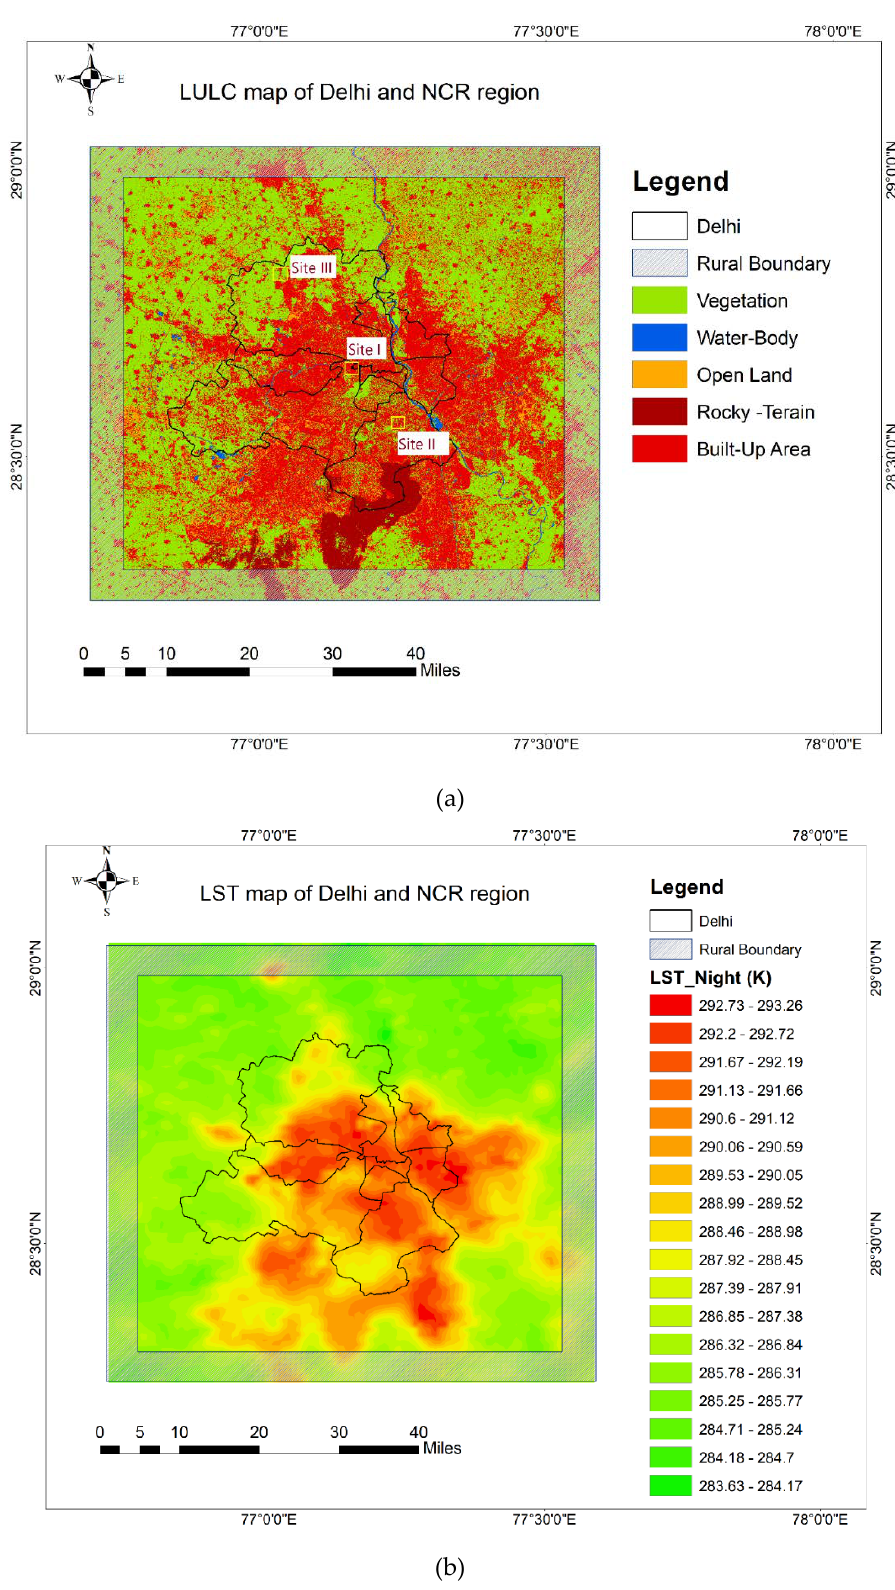
Figure 4. Land use land cover (a) and land surface temperature (b) map of Delhi (8 March 2018).